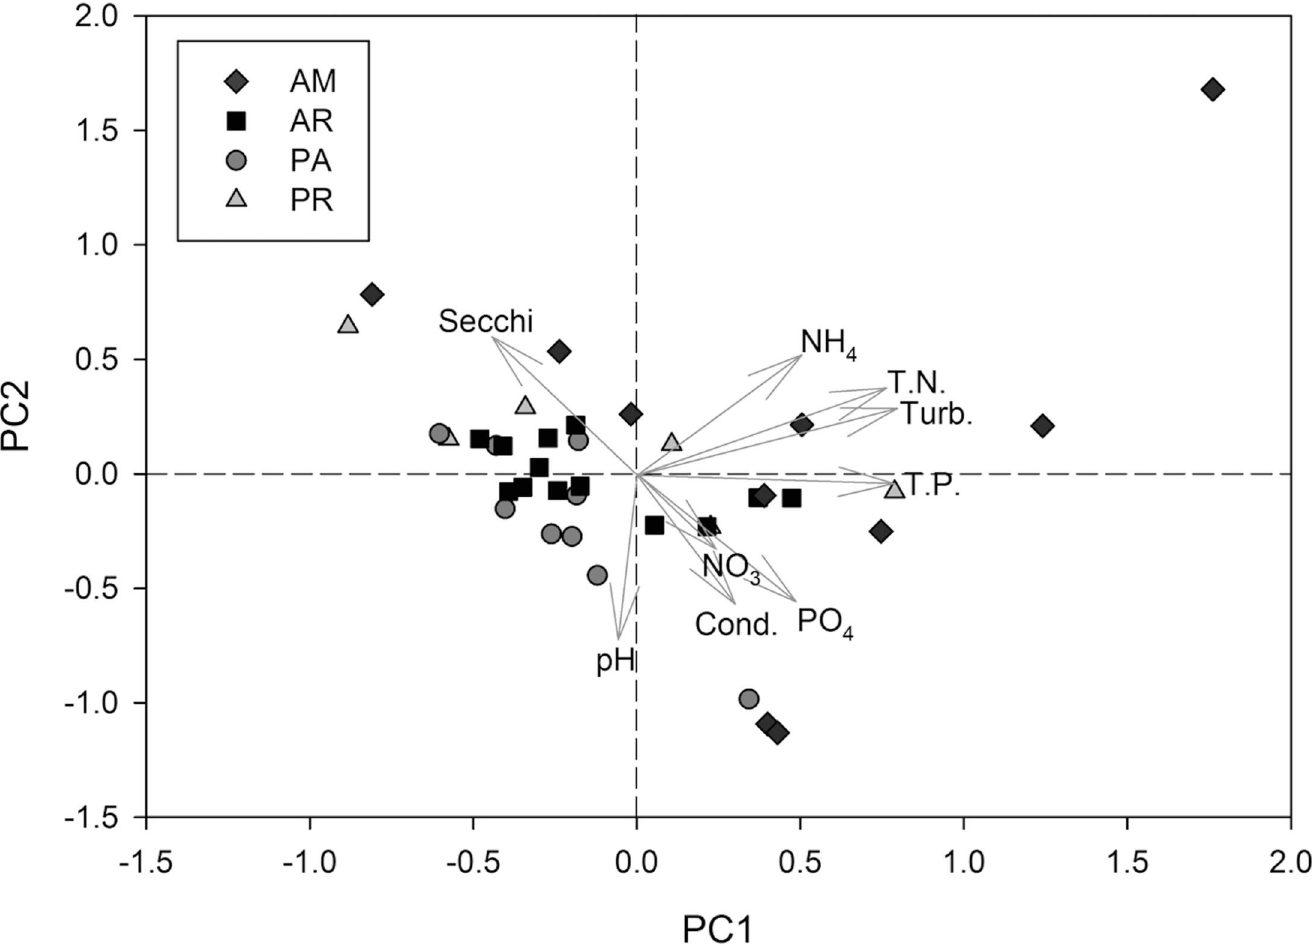
Fig 2. Principle coordinates analysis biplot of limnological conditions among sampling locations and basins. The first two axes explain59% of the variationamong sites (i.e. PC1 explained36% and 23% was explainedby PC2). AM = Amazon; AR = Araguaia;PA = Pantanal;PR = Parana´.